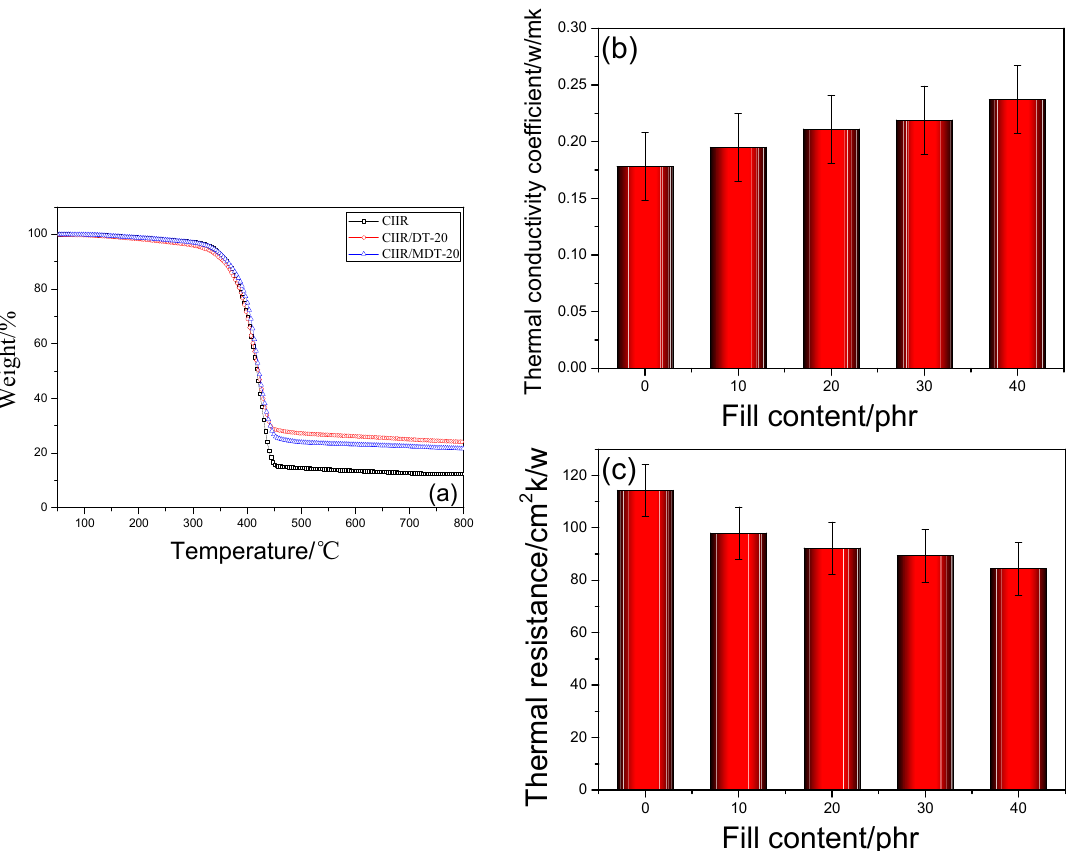
Figure 5. Thermal stability ( a ); thermal conductivity coefficient ( b ); and thermal resistance ( c ) of different CIIR composites.